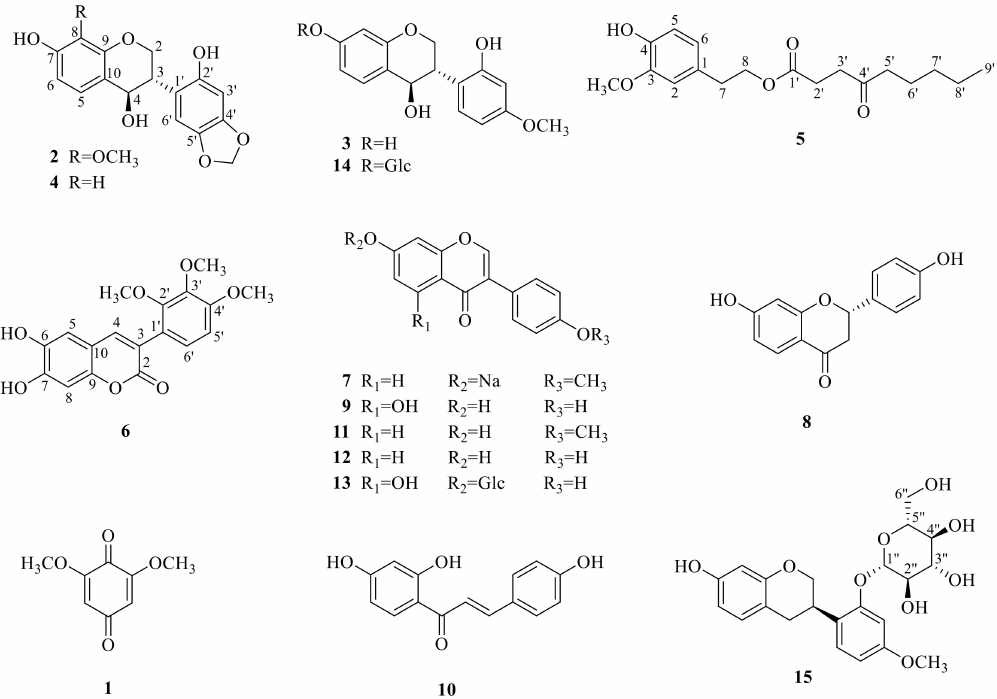
Figure 1. The structures of compounds 1 – 15 isolated from the vine stems of Spatholobus suberectus.